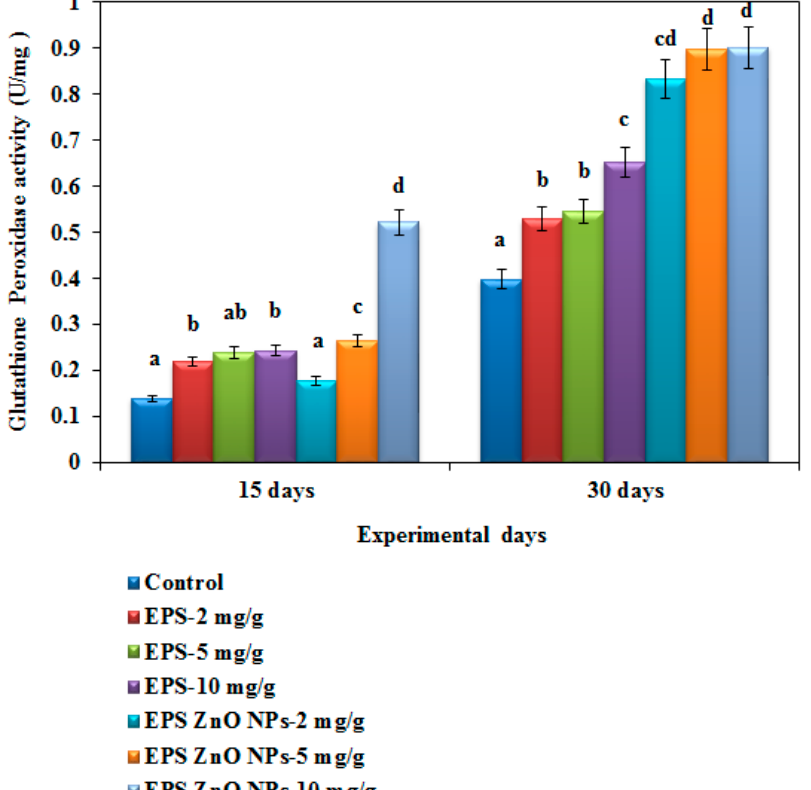
Figure 10. Glutathione peroxidase activity (GPx) of O. mossambicus fed with EPS and EPS-ZnO NPs. T-bars indicate three replicates of mean ± SD, and different letters correspond to the statistical difference between treated groups.